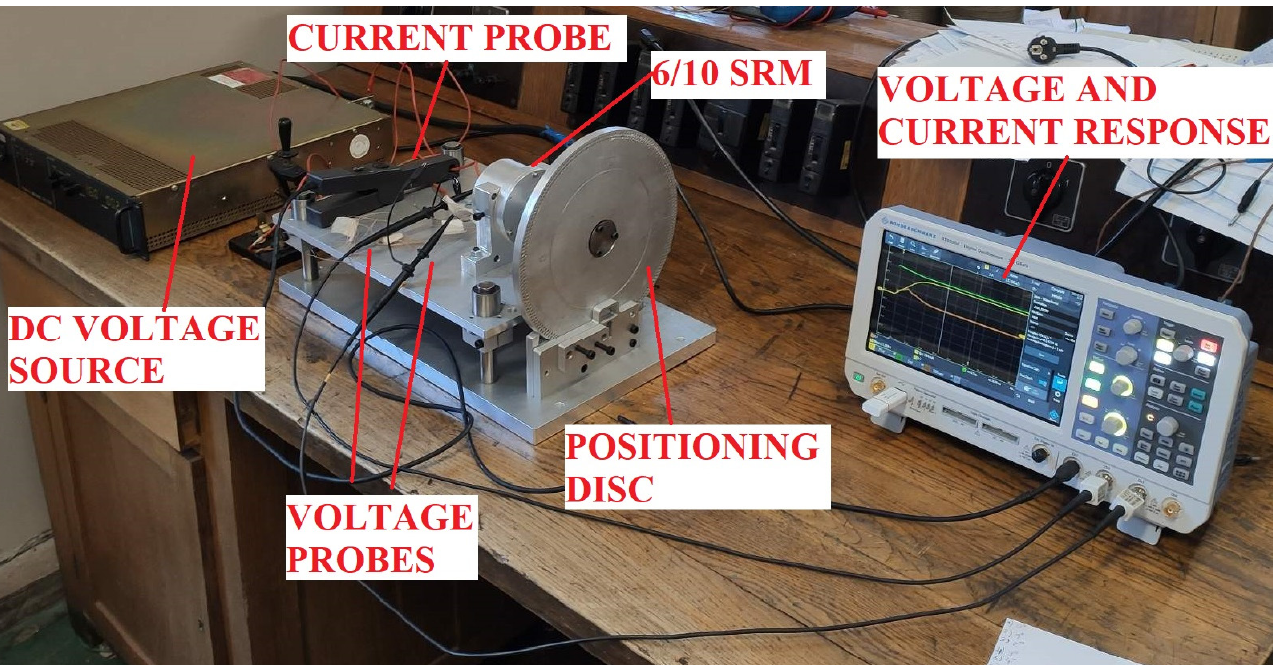
Figure 29. Test bench for determination of static electromagnetic characteristics of 6/10 SRM proto- type.